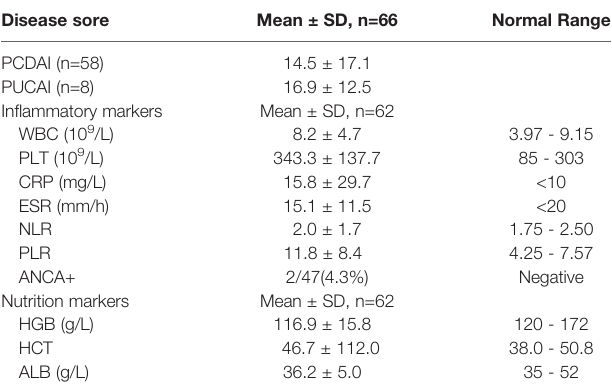
PIBD, pediatric in fl ammation bowel disease; PCDAI, pediatric Crohn ’ s disease activity index; PUCAI, pediatric ulcerative colitis activity index; WBC, white blood cells; PLT, platelets; CRP, C-reactive protein; ESR, erythrocyte sedimentation rate; NLR, neutrophil- to-lymphocyte ratio; PLR, platelet-to-lymphocyte ratio; ALB, albumin; HGB, hemoglobin; HCT, hematocrit; ANCA, Anti-neutrophil cytoplasmic